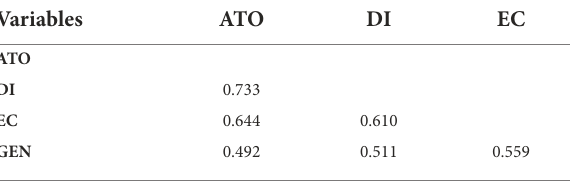
TABLE 5 Heterotrait-Monotrait Ratio (HTMT) analysis.